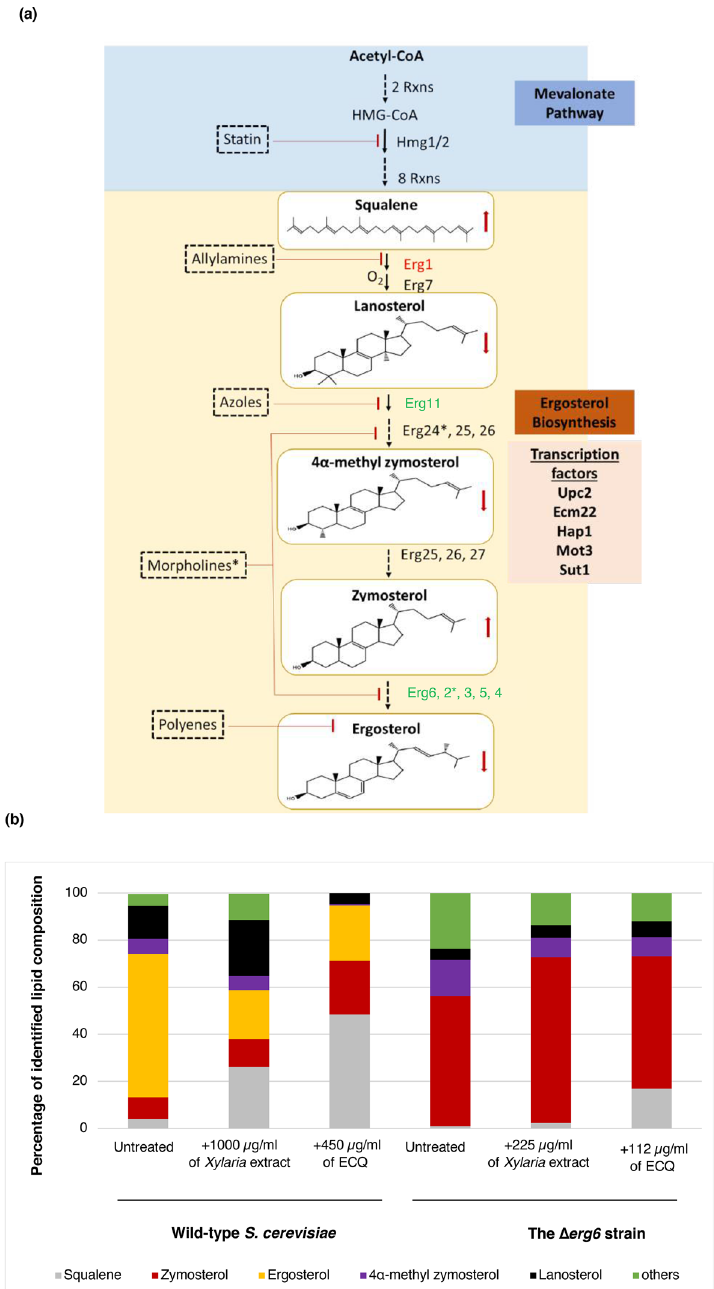
Figure 4. Alteration of sterol and TAG levels as well as formation of LDs clustering were examined during the ECQ treatment in S. cerevisiae . ( a ) ergosterol biosynthesis pathway in S. cerevisiae , including involved transcriptional factors and targets of antifungal drugs was depicted ( b ) percentage of identified sterol composition as quantified by GC–MS, ( c ) LDs formation and Nile Red fluorescent intensity, and the chromatograms of the change in ( d ) sterol composition and ( e ) TAG content of yeast cells after treatment with ECQ of S. cerevisiae wild-type and ∆ erg6 strains treated with the Xylaria extract or ECQ. Gene labelled in green or red colour indicated up- or down-regulated expression, respectively. Asterisks indicated target of Morpholines. Red arrows indicated increased or decreased accumulation of sterol level, following the ECQ treatment. “ND.” Was referred to “not detected”. Error bars represent standard error of the mean (SEM). Different letters above the error bars ( a – f ) indicate significant differences at p value of <